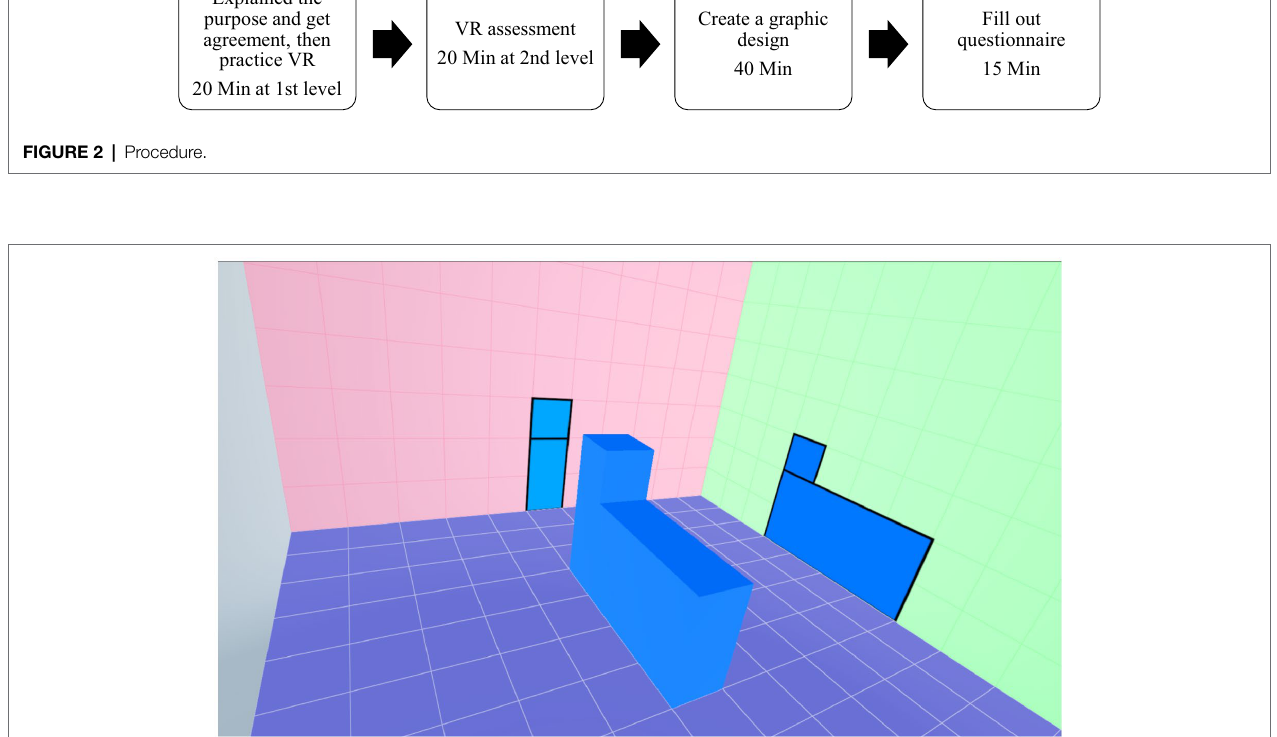
FIGURE 3 | An exemplary screenshot of the first level of spatial assessment.